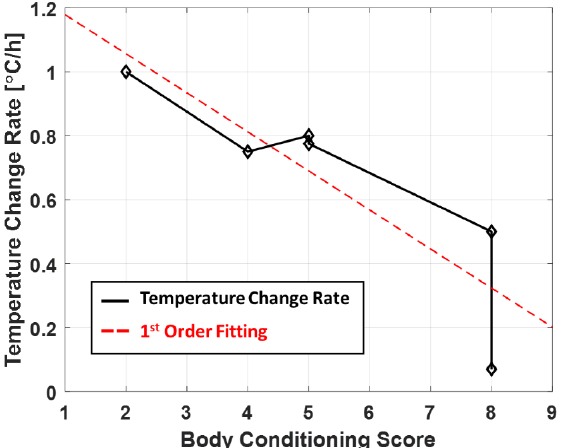
Figure 8. Correlation between body conditioning score (BCS) and core (rectum) temperature change rate. The subjects with a lower BCS, i.e., underweight subjects, showed the highest rate of temperature reduction (°C/h) during general anesthesia. The correlation coefficient between BCS and the rate of core temperature change is −0 .88 ( p = 0.0046, α < 0.05).